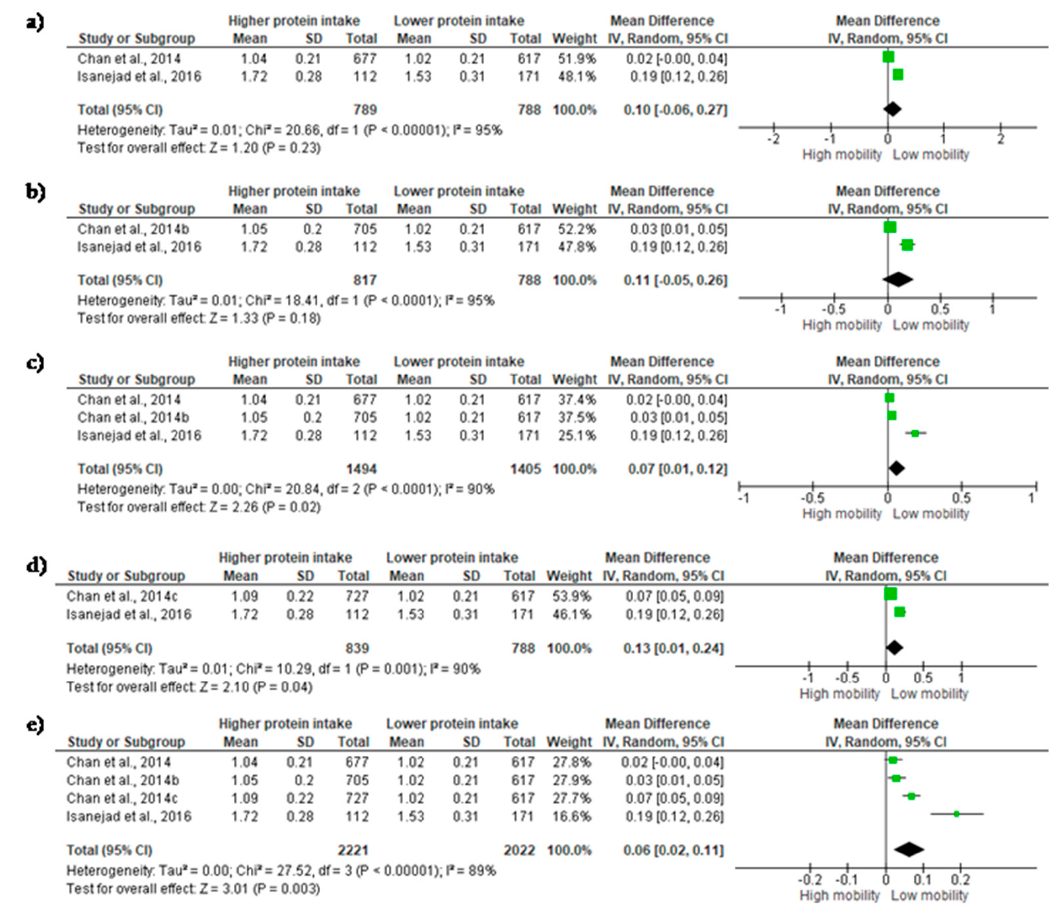
Figure 3. Mean differences in Mobility according to protein intake. ( a ) Chan et al., 2014, and Isanejad et al., 2016; ( b ) Chan et al., 2014b, and Isanejad et al., 2016; ( c ) Chan et al., 2014ab, and Isanejad et al., 2016; ( d ) Chan et al., 2014c, and Isanejad et al., 2016; ( e ) Chan et al., 2014abc, and Isanejad et al., 2016. Squares represent study-specific estimates; diamonds represent pooled estimates of random-effects meta-analyses.